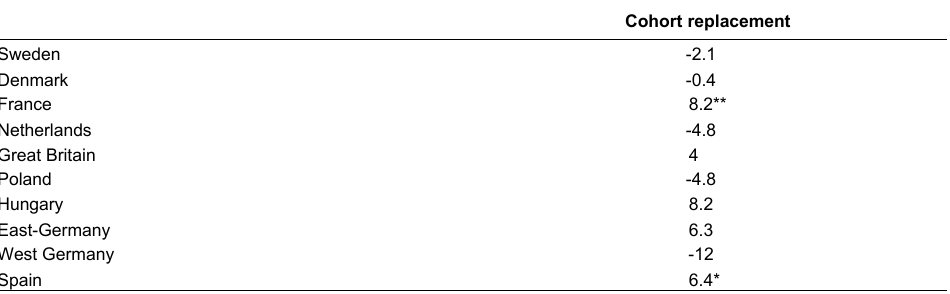
Table 2 : Cohort replacement effect in percentage point difference (no weights